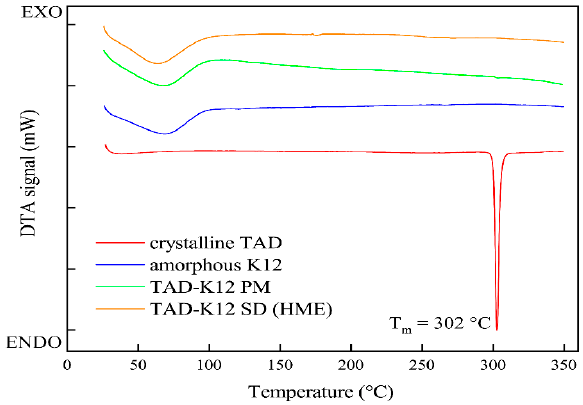
Figure A1. DSC thermograms of (from bottom to top) crystalline TAD, amorphous K12, TAD-K12 PM, and TAD-K12 SD (HME).